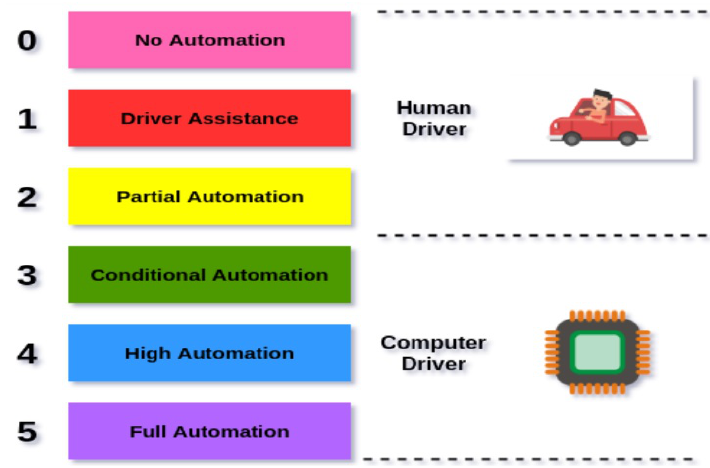
Figure 11. The stages of human driving and self driving